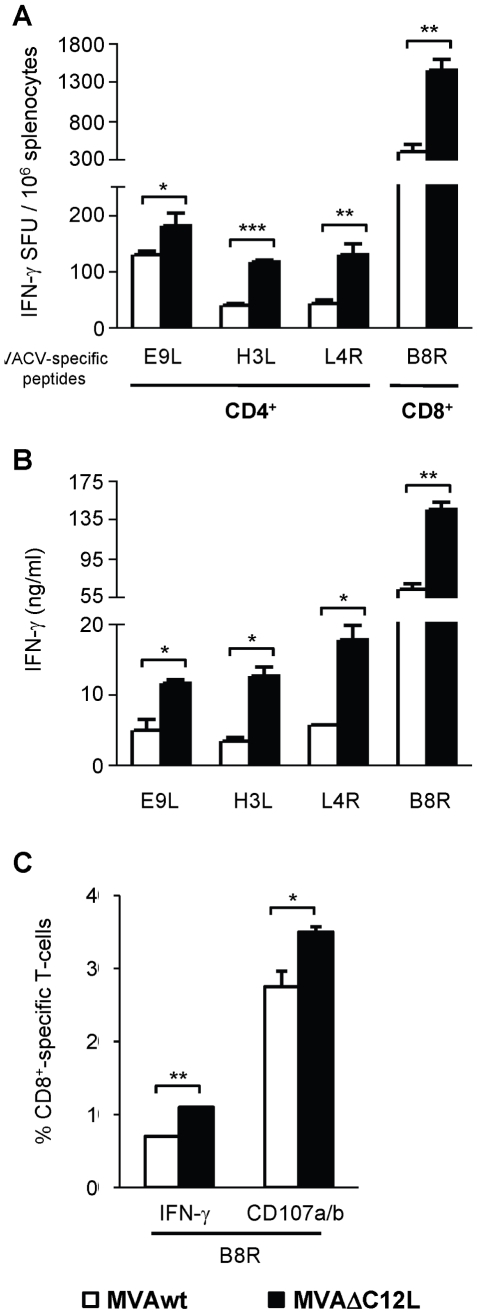
Immunogenicity of MVAΔC12L in C57BL/6 mice.Groups of four C57BL/6 mice were i.p vaccinated with 5×107 pfu of MVAwt (white bars) or MVAΔC12L (black bars) and seven dpi T-cell responses against VACV peptides B8R (CD8+-specific), E9L, H3L and L4R (CD4+-specific) were evaluated in the spleen. (A) The magnitude of the response was measured by IFN-γ Elispot assay after 24 hr stimulation. Background (RPMI negative control) subtracted results are depicted as mean IFN-γ spot forming units (SFU) per 106 splenocytes ± SD. (B) IFN-γ production in splenocyte-culture supernatants was evaluated by ELISA after 72 hr stimulation. (C) Quality of the response was analyzed by ICS. Degranulation of specific-CD8+ T-cells was assessed with CD107a/b mAb together with IFN-γ production, after 5 hr stimulation with the indicated peptides. Results are expressed as mean % of specific CD8+ T-cells ± SD. Statistically significant differences: *p<0.05, **p<0.01, ***p<0.001.